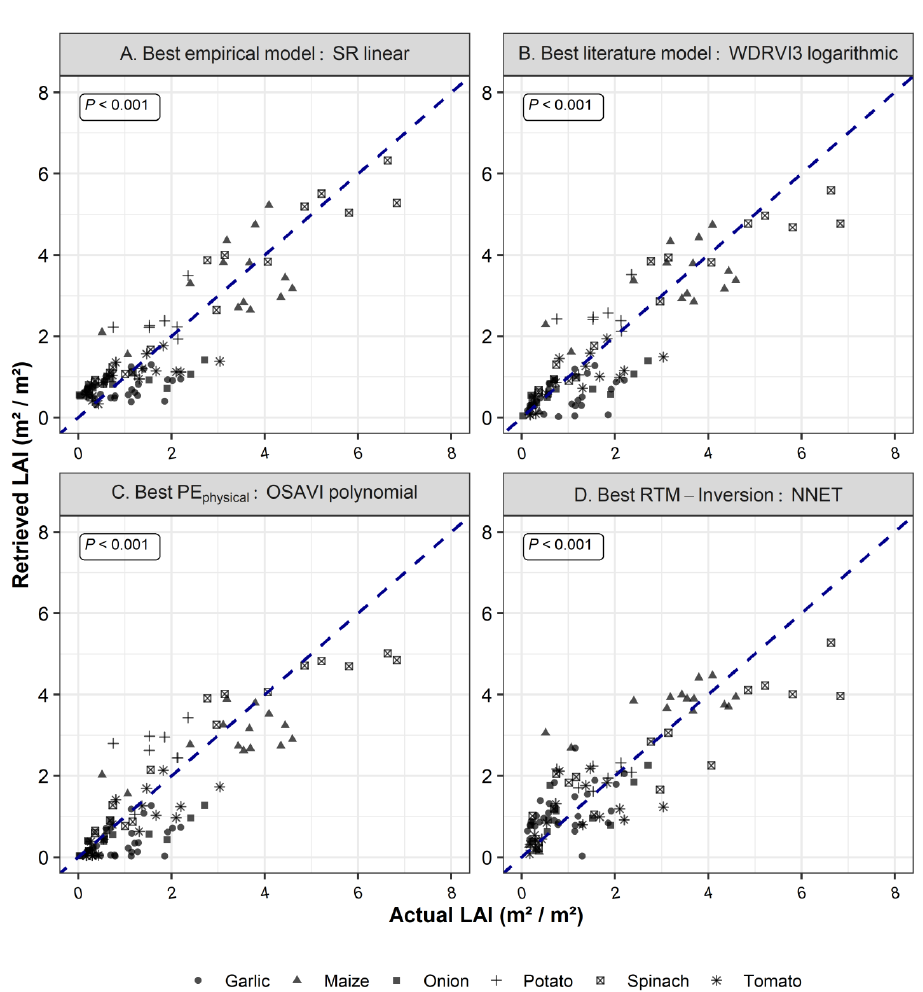
Figure 6. Retrieved versus measured LAI using the best statistical approaches and physical ap- proaches ( A ) best empirical model: linear regression between LAI and SR; ( B ) best literature model: WDRVI3 (i.e., [52]); ( C ) Best PE physical model: based on OSAVI-second-order polynomial fitting; ( D ) best RTM-inversion using PROSAIL: NNET .